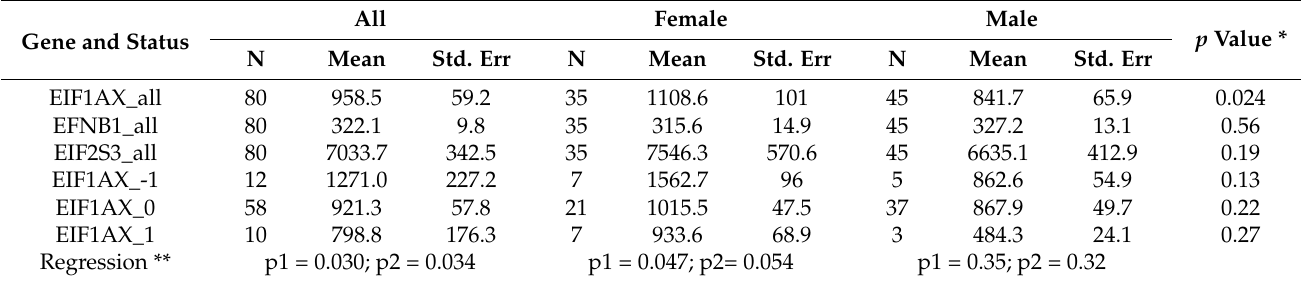
Table 2. Sex difference in EIF1AX mean mRNA levels and their inverse correlation with copy numbers of EIF1AX. Gene and